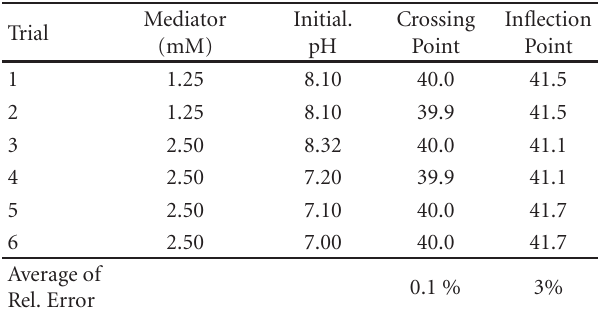
Table 3: Errors in determining equivalence point: volume (mL) of Ag + required using Na 2 HPO 4 .